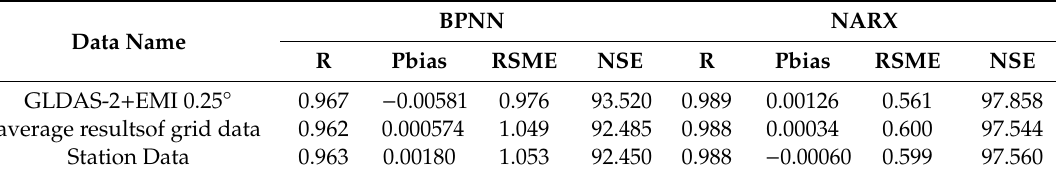
Table 7. Modeling results using grid products and station